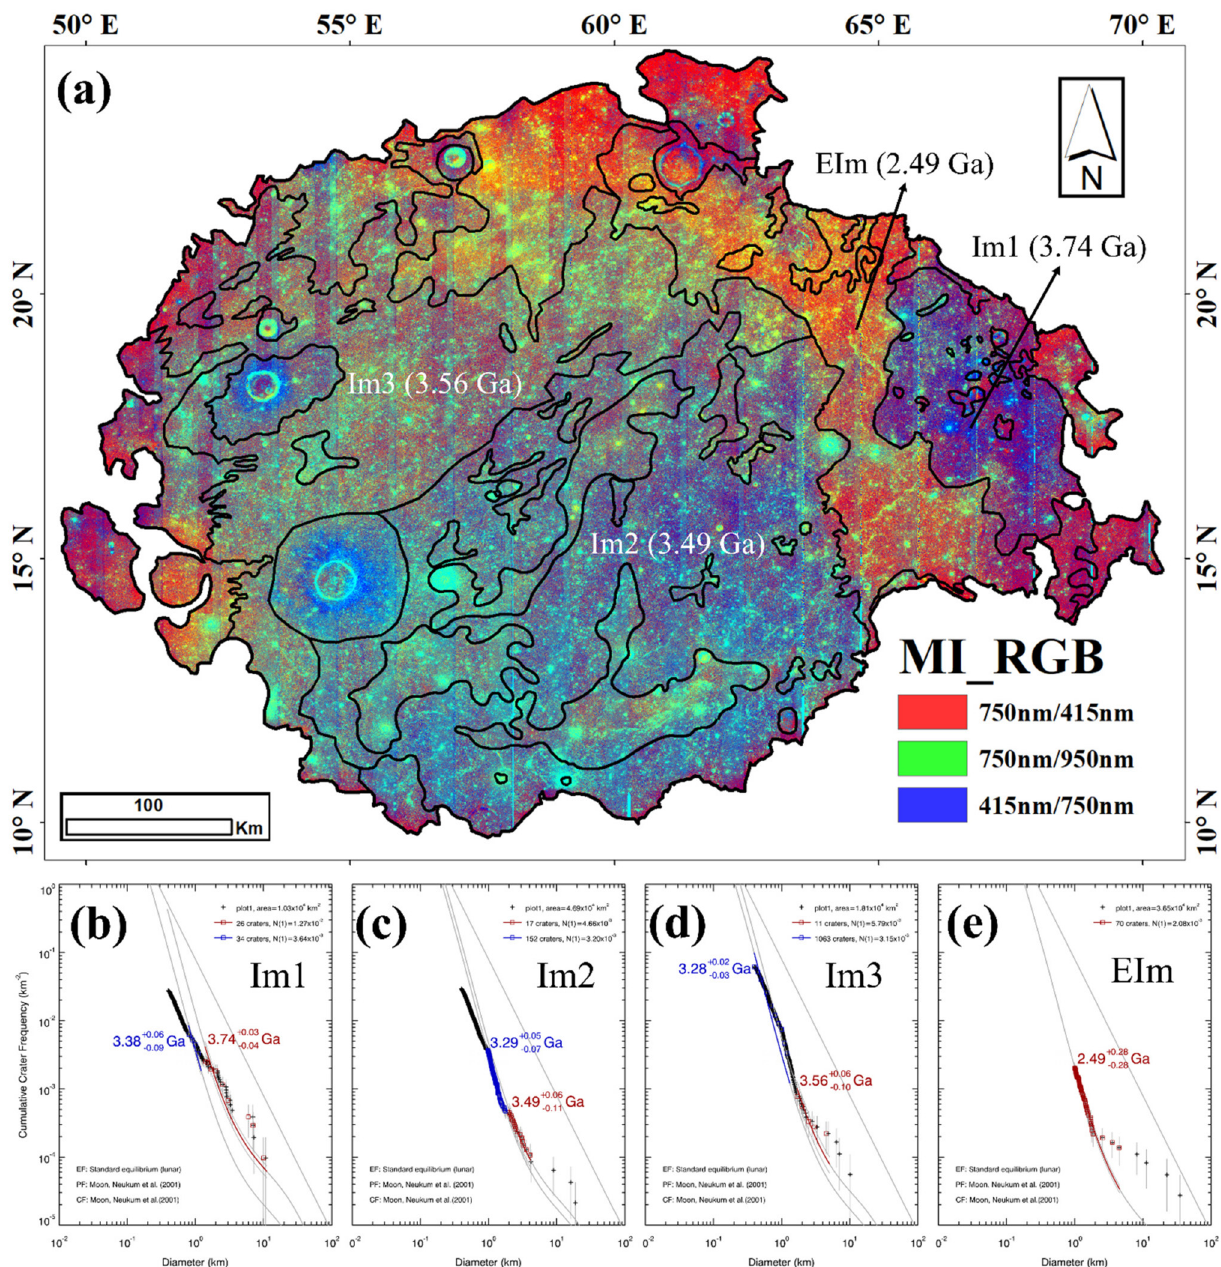
Figure 12. ( a ) False-color composite map derived from Kaguya-MI data with red (750 nm/415 nm), green (750 nm/950 nm), and blue (415 nm/750 nm). The cumulative crater frequency plots and AMAs of mare units (( b ) Im1 , ( c ) Im2 , ( d ) Im3 and ( e ) EIm ) are analyzed in Table 1 for